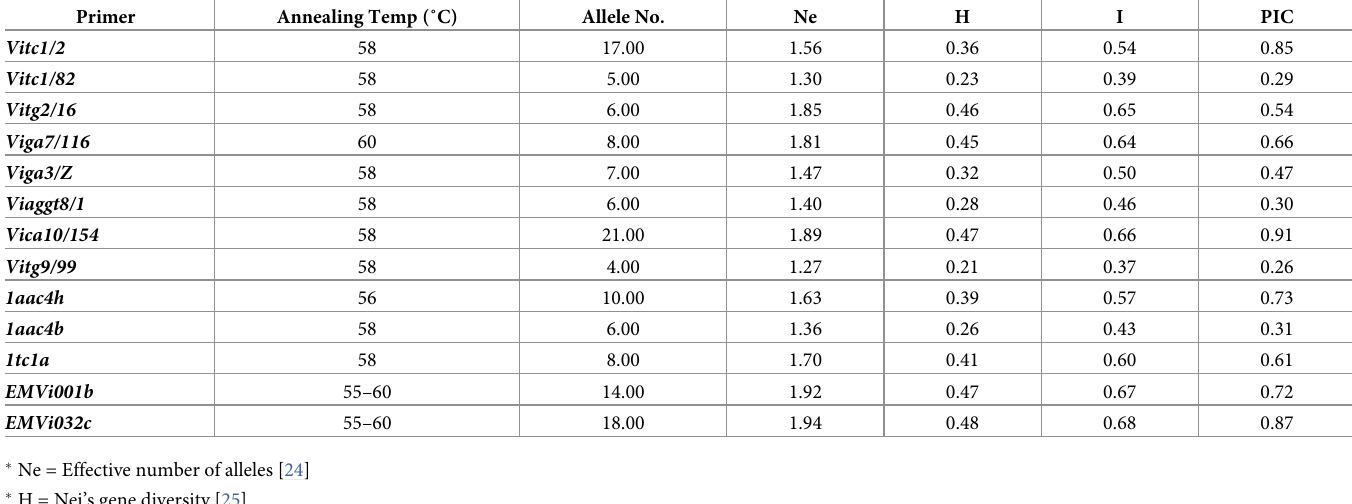
Table 1. Summary of the genetic analysis results for Venturia inaequalis isolates according to 13 SSR loci. Primer Annealing Temp (˚C) Allele